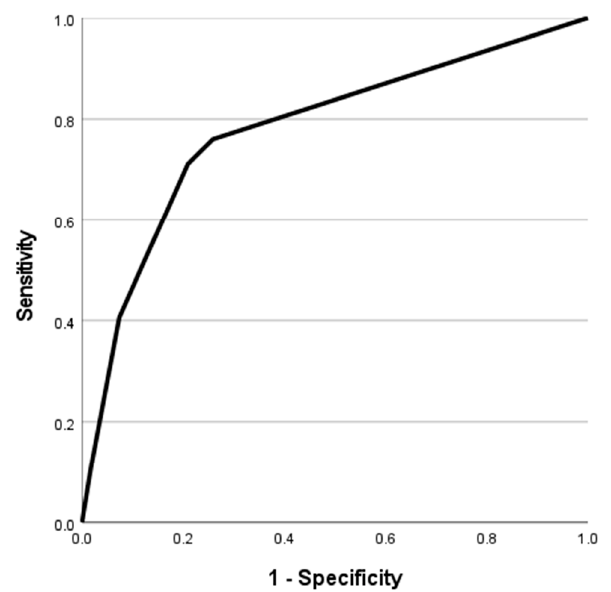
Figure 3. Receiver operating characteristics (ROC) curve of Longitudinal Interval Follow-up Evaluation (LIFE) depression score—sensitivity and specificity in determining “mildly depressed” status (defined by Montgomery-Asberg Depression Rating Scale [MADRS] score > 12).